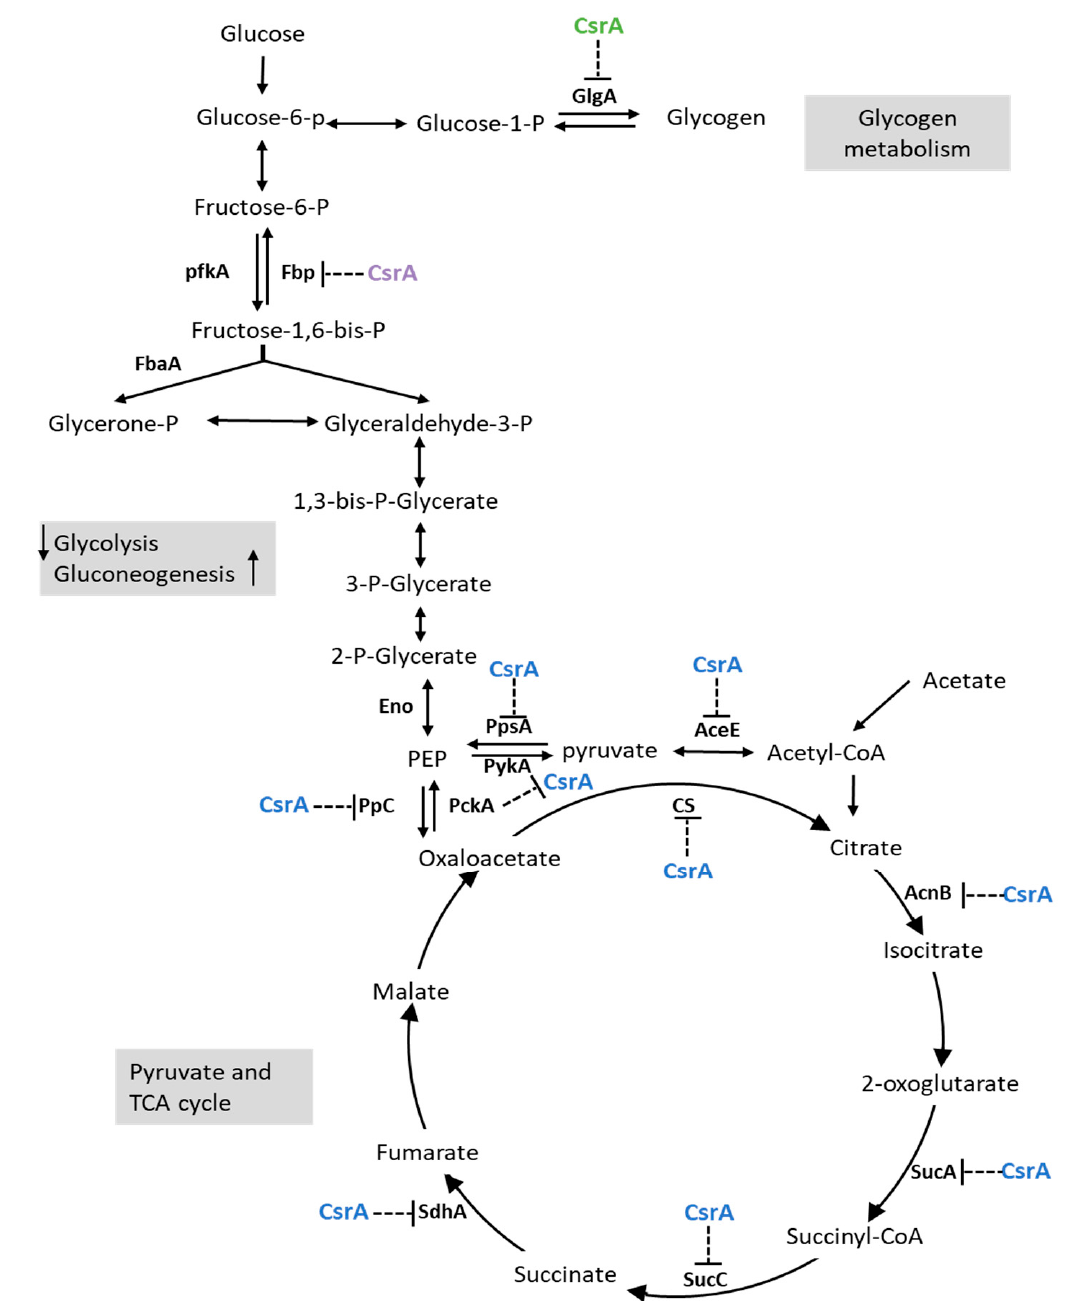
Figure 6. Post-transcriptional regulation of the central carbon metabolic pathways in V. alginolyticus . Effects of the RNA-binding protein CsrA on the synthesis of enzymes involved in glycogen metabolism, glycolysis, gluconeogenesis, and the pyruvate and TCA cycles. Green, blue, and purple represent glycogen metabolism, glycolysis and gluconeogenesis, and the pyruvate and TCA cycles respectively. GlgA, glycogen synthase; PfkA, 6-phosphofructokinase; FbaA, fructose-bisphosphate aldolase; FBP, Fructose-1,6-bisphosphatase; Eno, phosphopyruvate hydratase; PykA, pyruvate kinase II; AceE, pyruvate dehydrogenase (acetyl-transferring); AcnB, bifunctional aconitate hydratase 2/2-methylisocitrate dehydratase; CS, citrate (Si)-synthase; SucA, 2-oxoglutarate dehydrogenase; SucC, succinyl-CoA synthetase, SdhA, succinate dehydrogenase catalytic; PckA, phosphoenolpyruvate carboxykinase; PpC, phosphoenolpyruvate carboxylase; PpsA, phosphoenolpyruvate synthase; FruA, PTS fructose transporter subunit